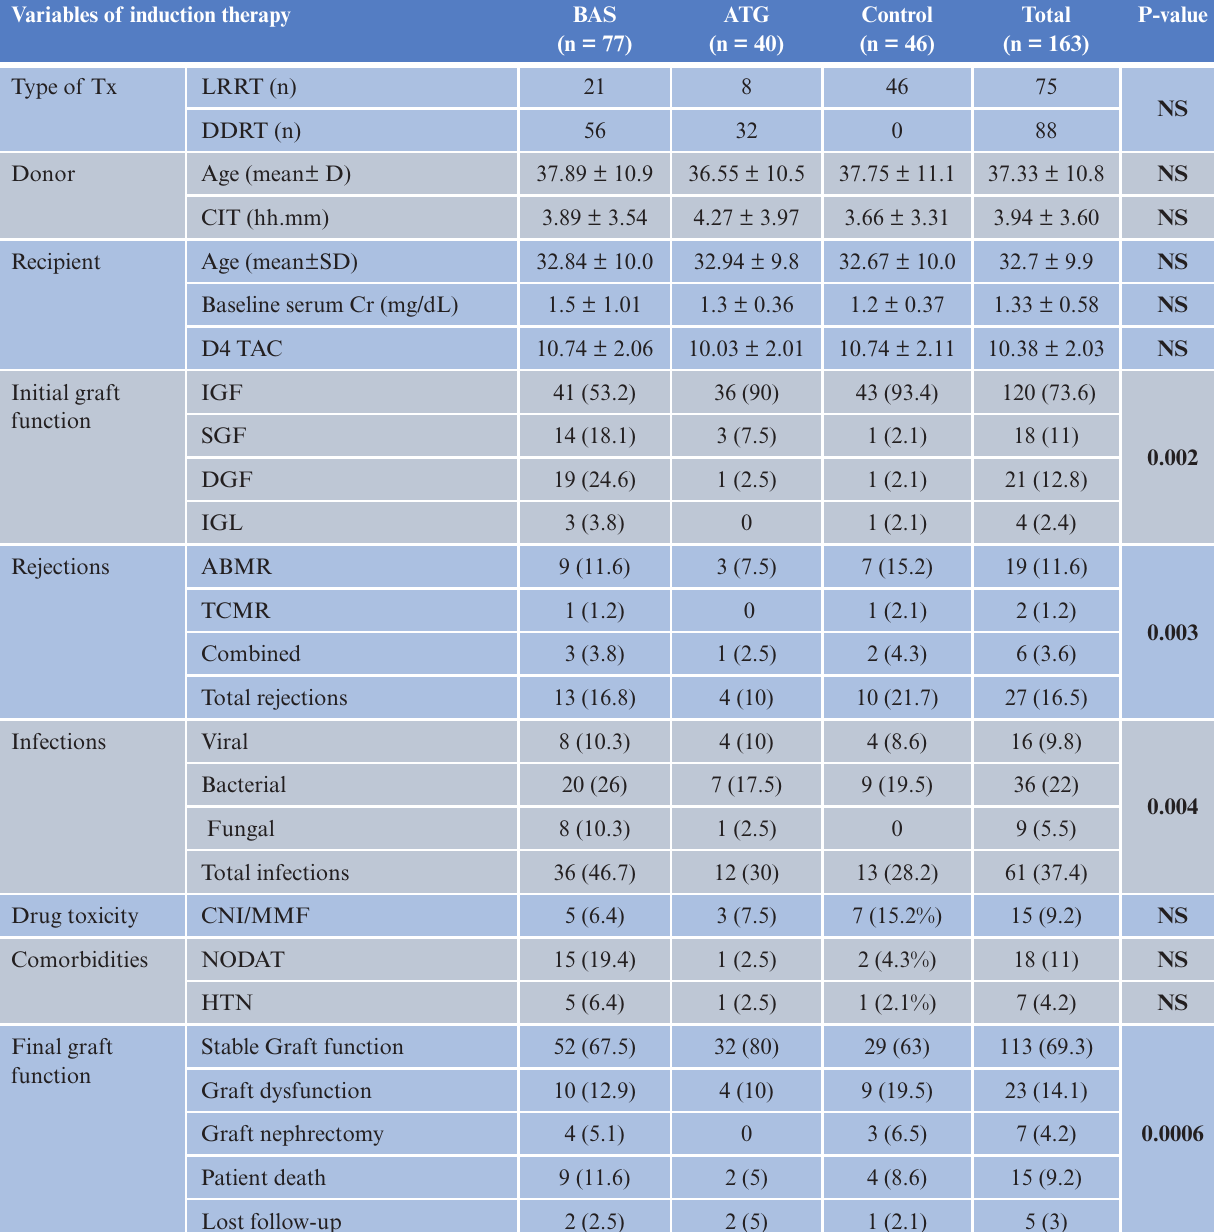
Table 1: Cumulative outcome measures of kidney transplant recipients on the basis of induction type; data are presented as mean ± SD or number